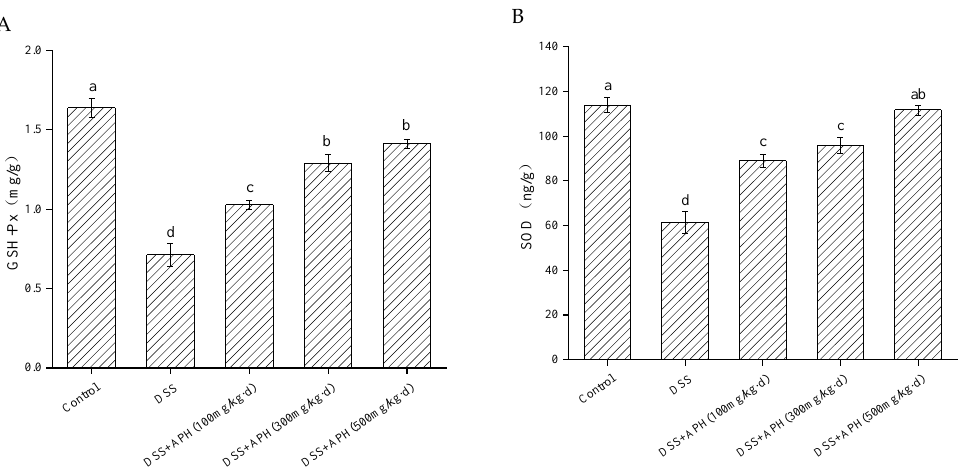
Figure 4. Effects of APH on the oxidative stress-related indicators, including the colonic concentra- tions of GSH-Px ( A ) and SOD ( B ). Data are expressed as mean ± SD ( n = 8). Different letters indicate significant differences ( p < 0.05).